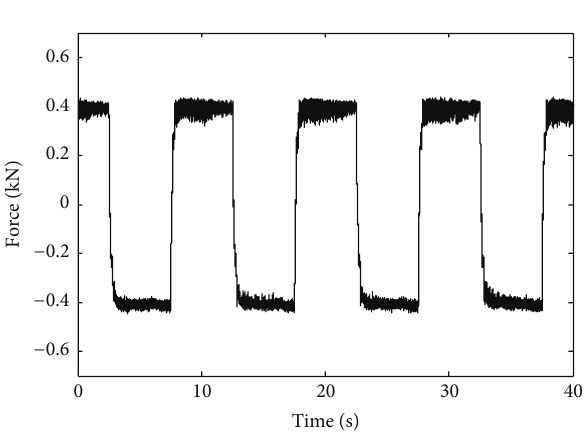
Figure 4: Force in 0.1